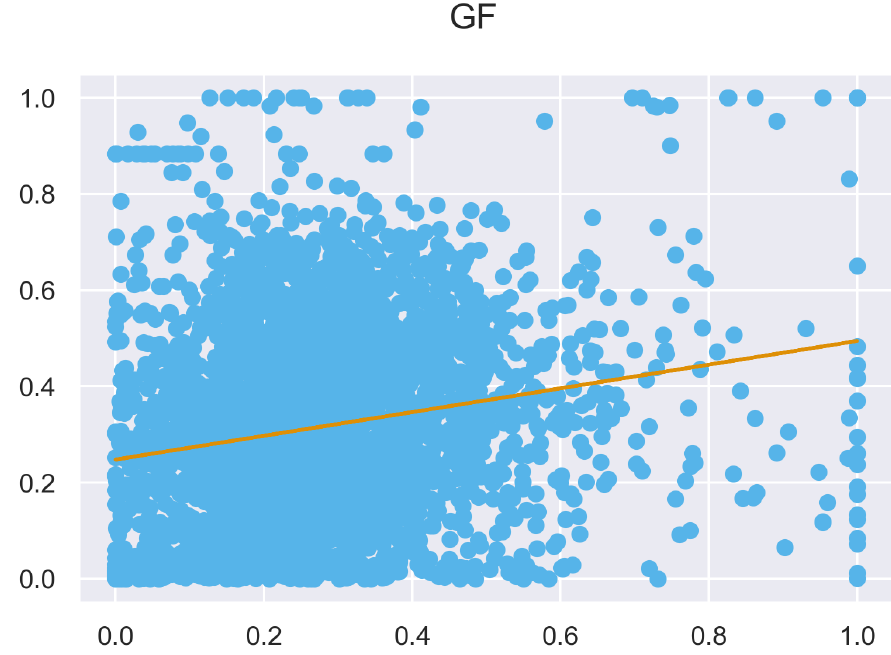
Figure A29. ULS and TLS GF regression at 1m grid